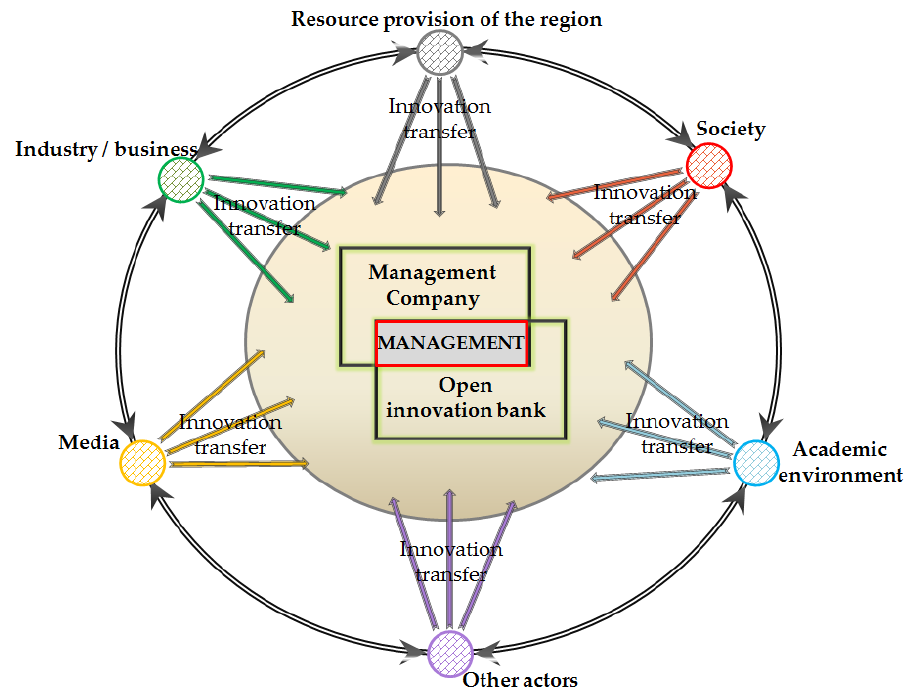
Figure 4. The schematic view for a model implementing the concept of open innovation based on the cluster and ecosystem approaches.